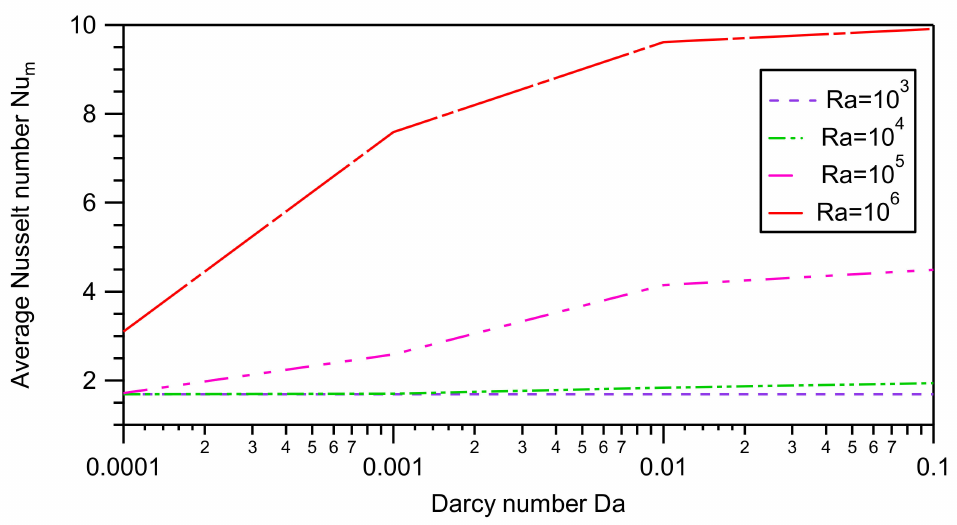
Figure 10. The streamlines for di ff erent values of Darcy numbers (Da = 10 − 4 , 10 − 3 , 10 − 2 and 10 − 1 ) and Rayleigh numbers (Ra = 10 3 , 10 4 , 10 5 and 10 6 ), Ha = 15, AR = 0.3, ω = 0, ϕ = 0.04, Fr = 0.75 and q ∗ = 1.